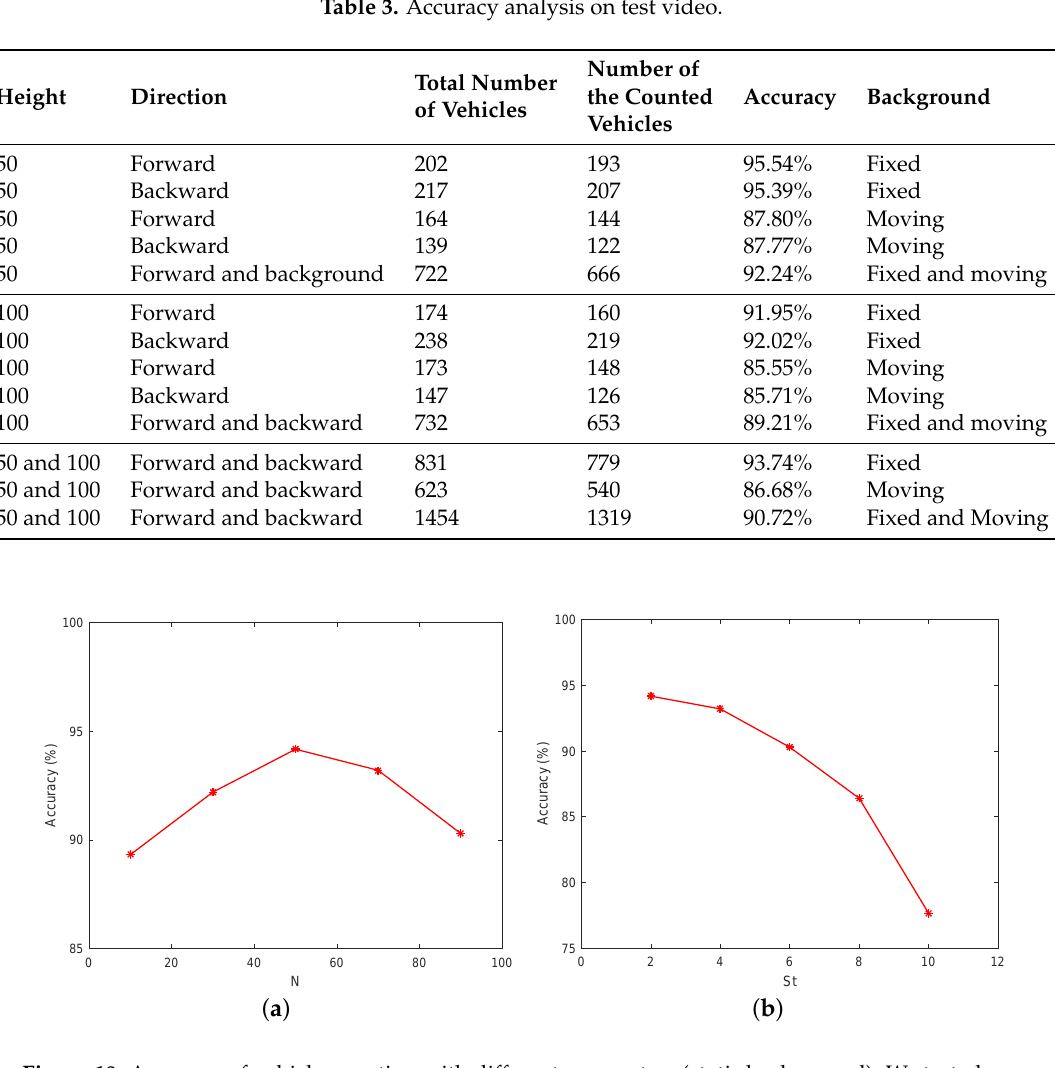
Figure 10. Accuracy of vehicle counting with different parameters (static background). We tested our method on a video of static background scene with different parameters: ( a ) the effect of N on